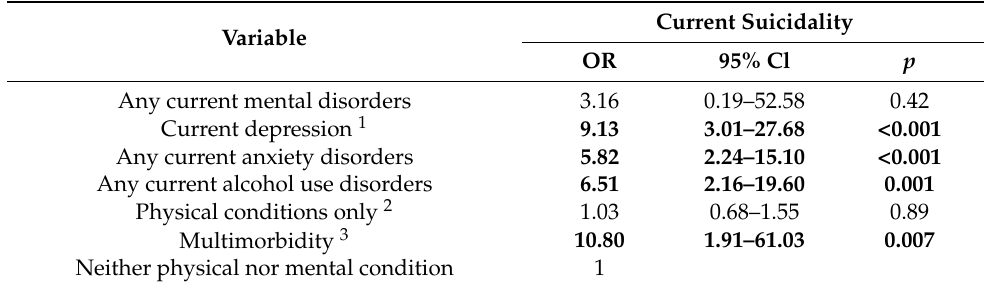
Table 2. Association of physical and mental conditions with current suicidality in multivariate logistic regression